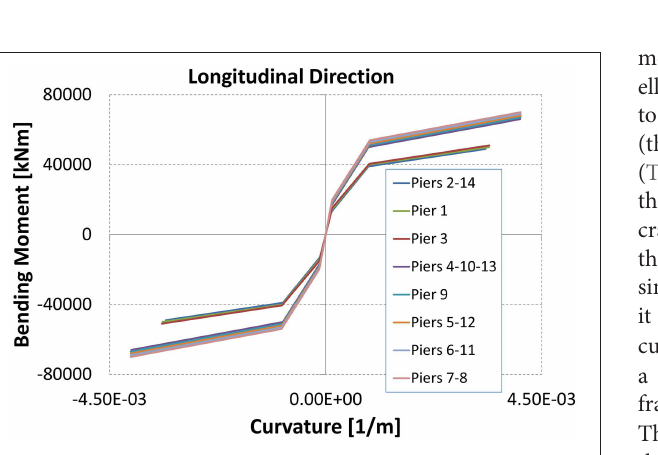
FIGURE 5 | Piers: moment–curvature